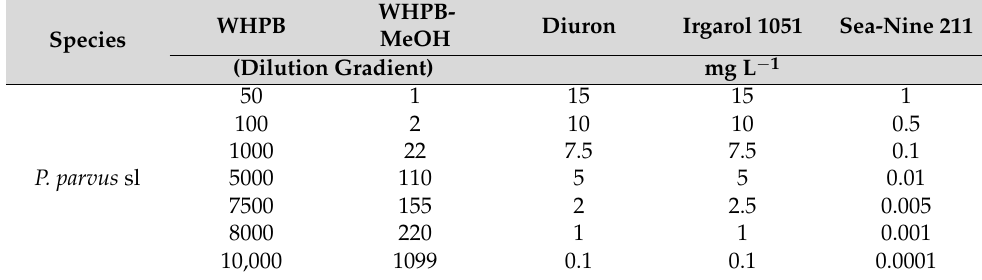
Table 1. Experimental conditions of wastewater (WHPB and WHPB-MeOH) from high-pressure water blasting and three booster biocides (Diuron, Irgarol 1051, and Sea-nine 211). WHPB- WHPB Diuron Irgarol 1051 Sea-Nine 211 MeOH Species (Dilution Gradient) mg L − 1 50 1 100 P. parvus sl 7500 220 0.001 10,000 1099